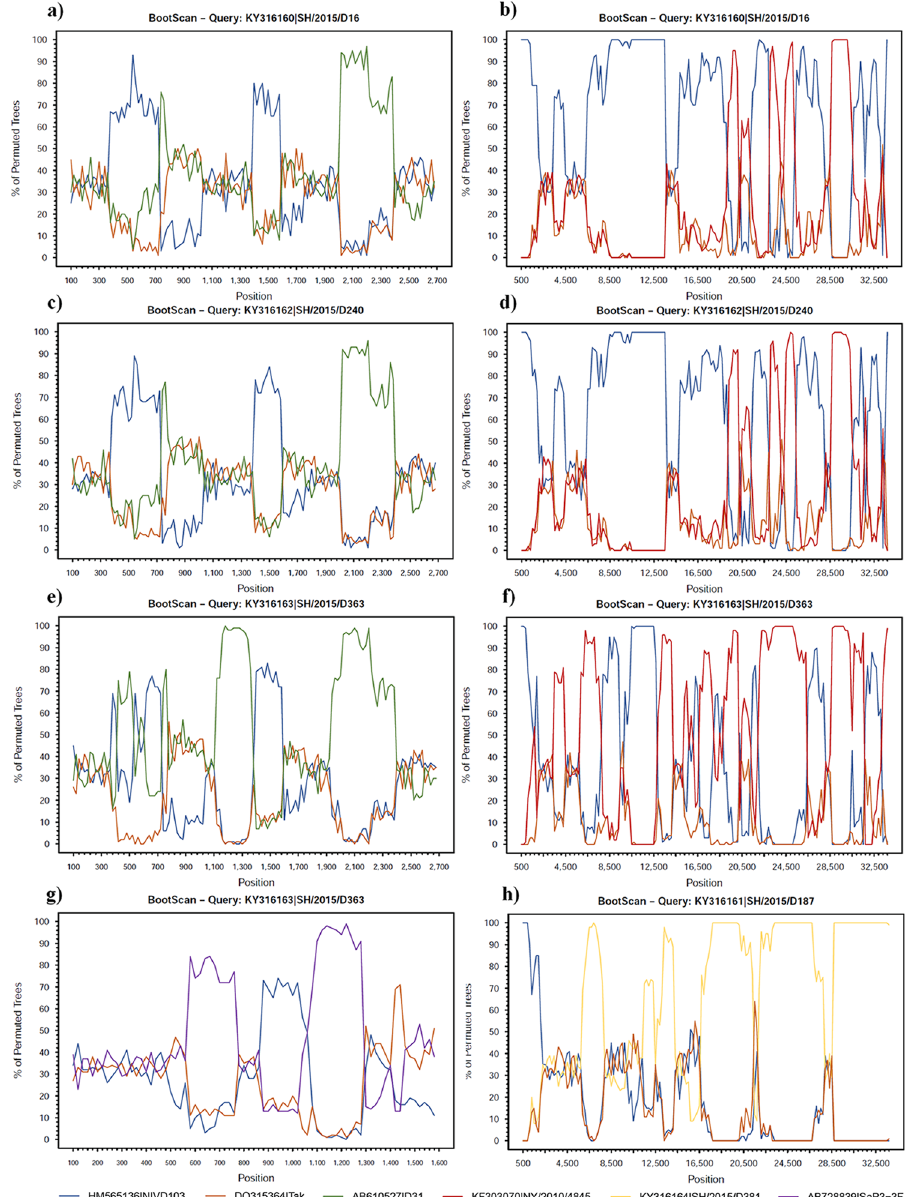
Figure 5. Bootscan plots of hexon, long fiber and whole genome sequences of the recombinant isolates. ( a ) Hexon of SH/2015/D16; ( b ) genome of SH/2015/D16; ( c ) hexon of SH/2015/D240; ( d ) genome of SH/2015/ D240; ( e ) hexon of SH/2015/D363; ( f ) genome of SH/2015/D363; ( g ) long fiber of SH/2015/D363; and ( h ) genome of SH/2015/D187. The analysis of genes is set with a window size of 100 bp and a step size of 20 bp, while whole genomes with a window size of 1000 bp and a step size of 200 bp. The query isolates are listed above each parts of the figure, and the references are colored accordingly in the color schemes under the